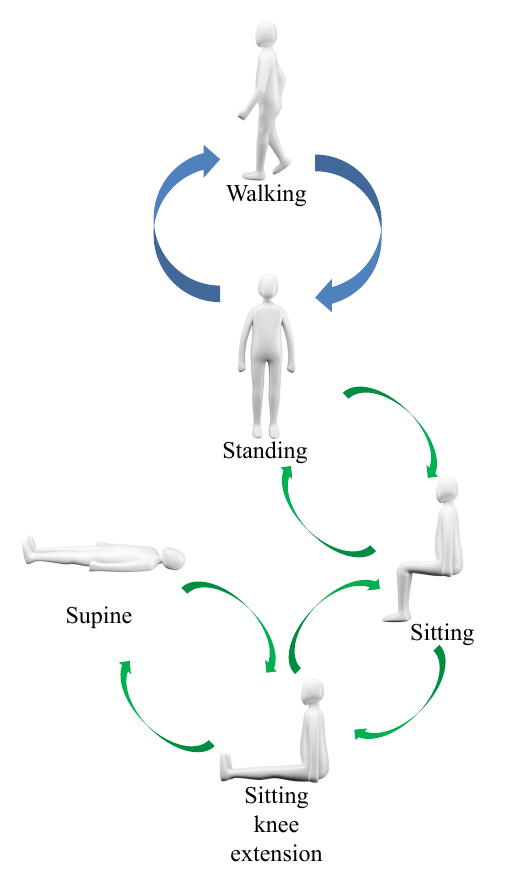
Figure 7. Flow chart for motion and posture decisions.